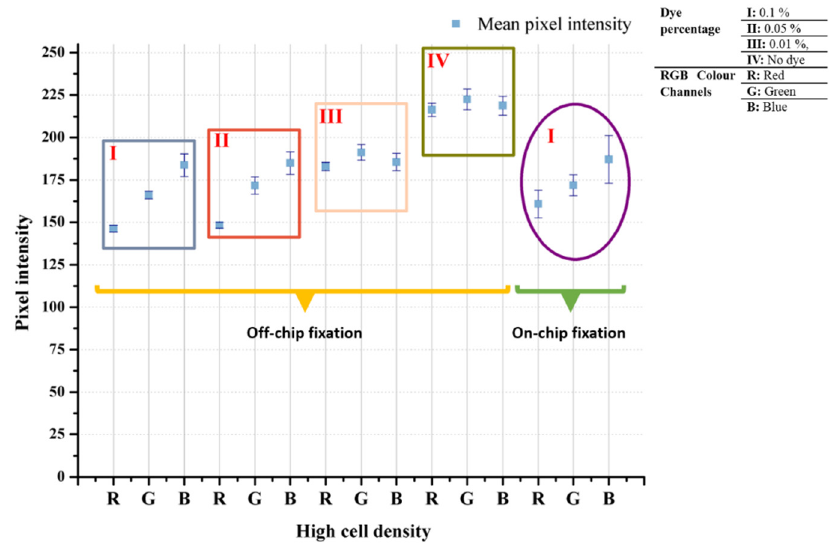
Figure 4. Trypan blue concentration effect on cell staining on off-chip and on-chip configuration. The 0.1%, 0.05%, and 0.01% TB dilutions from 0.4% stock solution were used on high number of